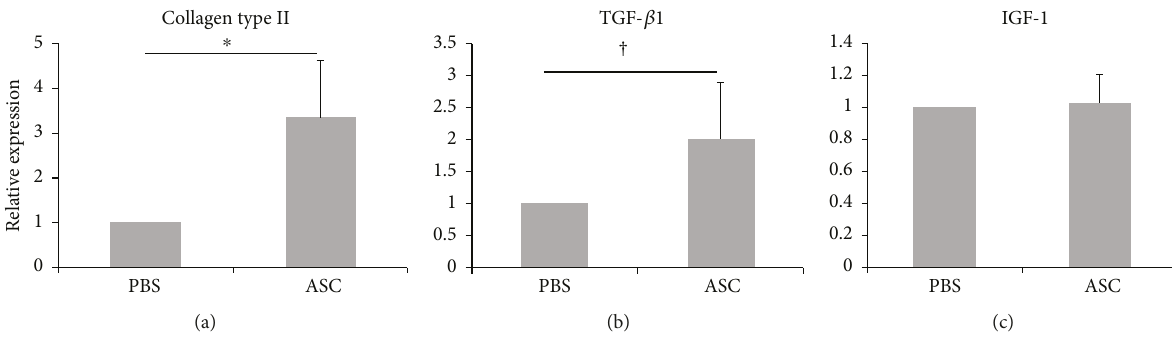
Figure 6: Expression of collagen type II, TGF- β 1, and IGF-1. The relative expression of collagen type II (a) and TGF- β 1 (b) were signi fi cantly higher in the ASC group than in the PBS group. However, there was no signi fi cant di ff erence in the expression of IGF-1 between the ASC and PBS groups (c). Data are expressed as the mean ± SEM. ∗ p = 0 008 and † p = 0 016 . ASCs, adipose-derived stem cells; PBS, phosphate-bu ff ered